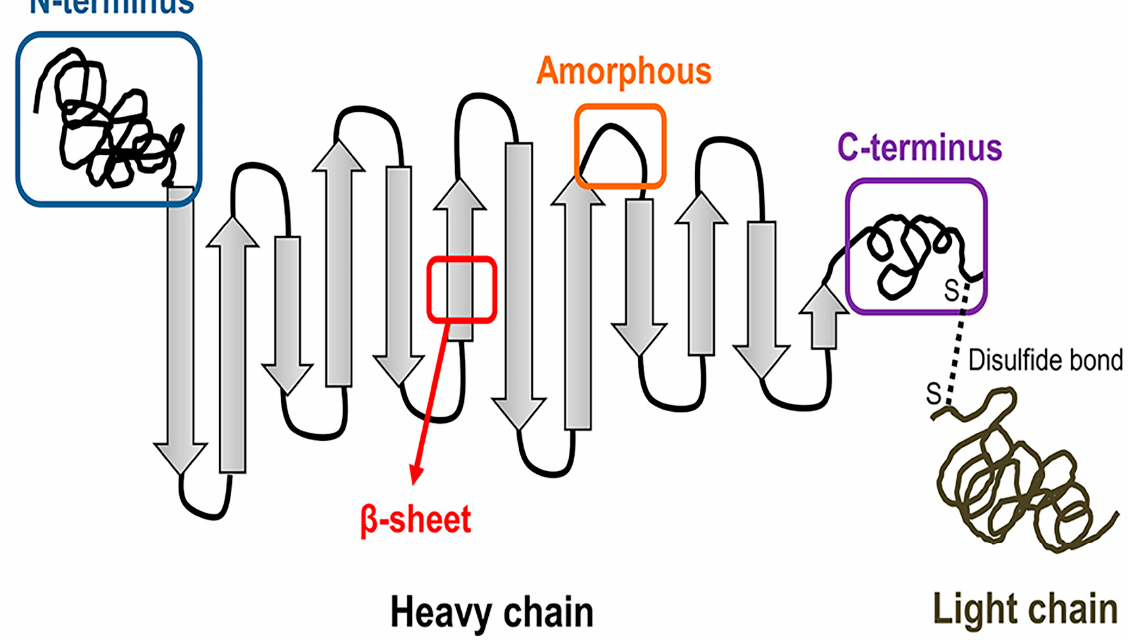
Figure 1. Structure diagram of silk fibroin (SF). The hydrophobic heavy (H-) chain and hydrophilic light (L-) chain are linked by disulfide bonds. Reproduced with permission from [47]. Copyright © 2018 American Chemical Society.